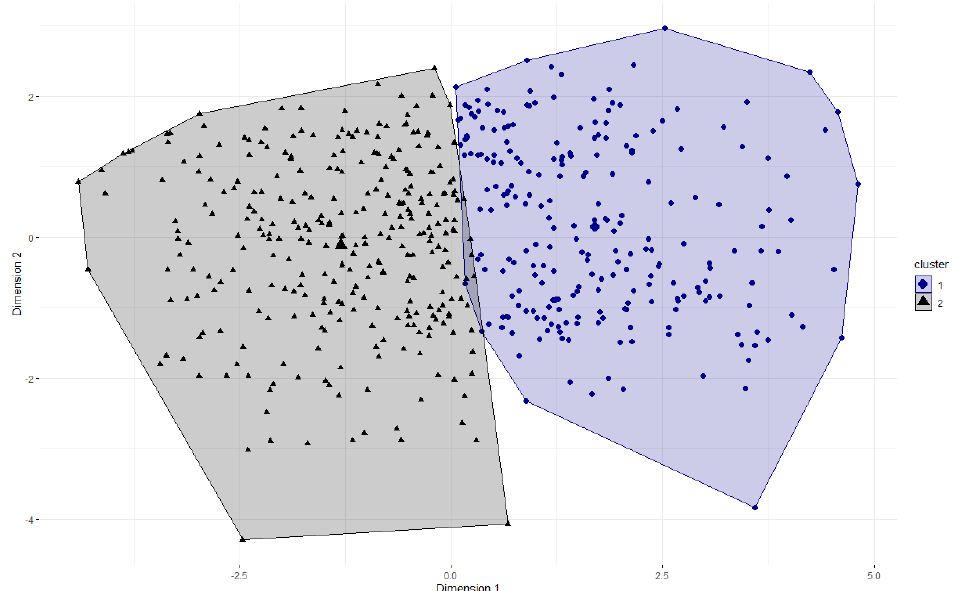
Figure 1. Partitioning clustering plot of the DBI-S with two clusters. A principal component analysis was used to determine two dimensions for visualization of the two-dimensional graph. The numbers on the X-/Y-axes indicate the z-scaled values of the dimensions. The cluster centers are displayed by larger symbols.